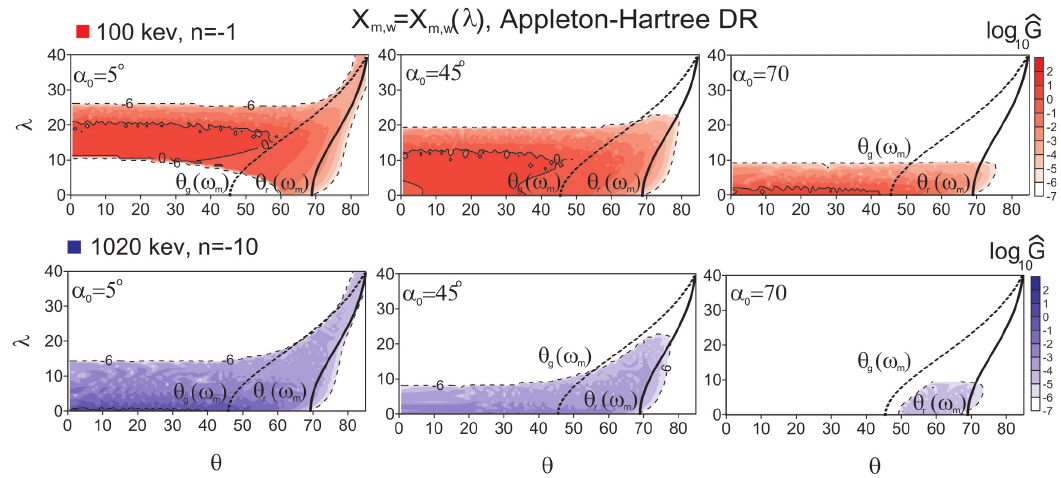
Fig. 9. Function ˆ G(θ,λ) for two n and particle energies (see text for details). Here (cid:127) pe /(cid:127) c0 = 4 . 5.